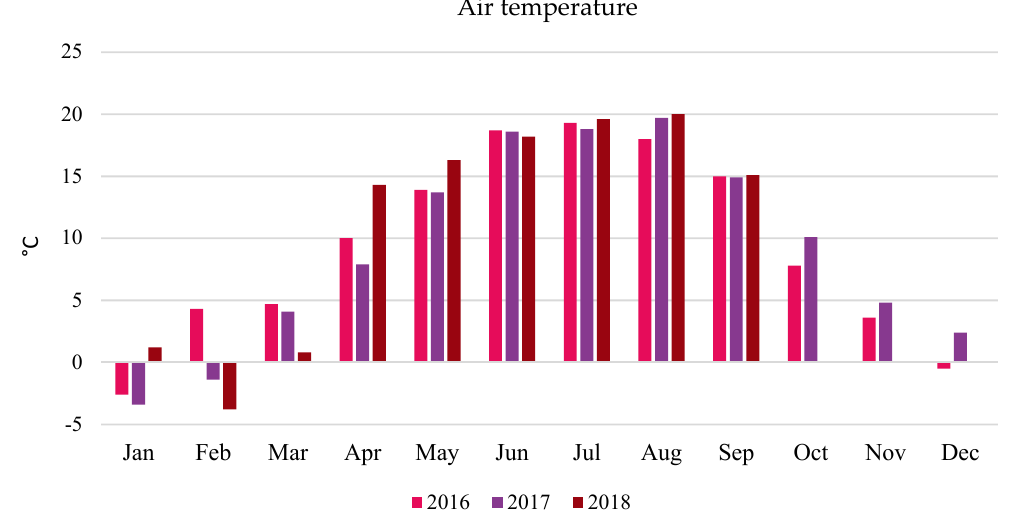
Figure 1. Air temperature from 2016 to 2018.